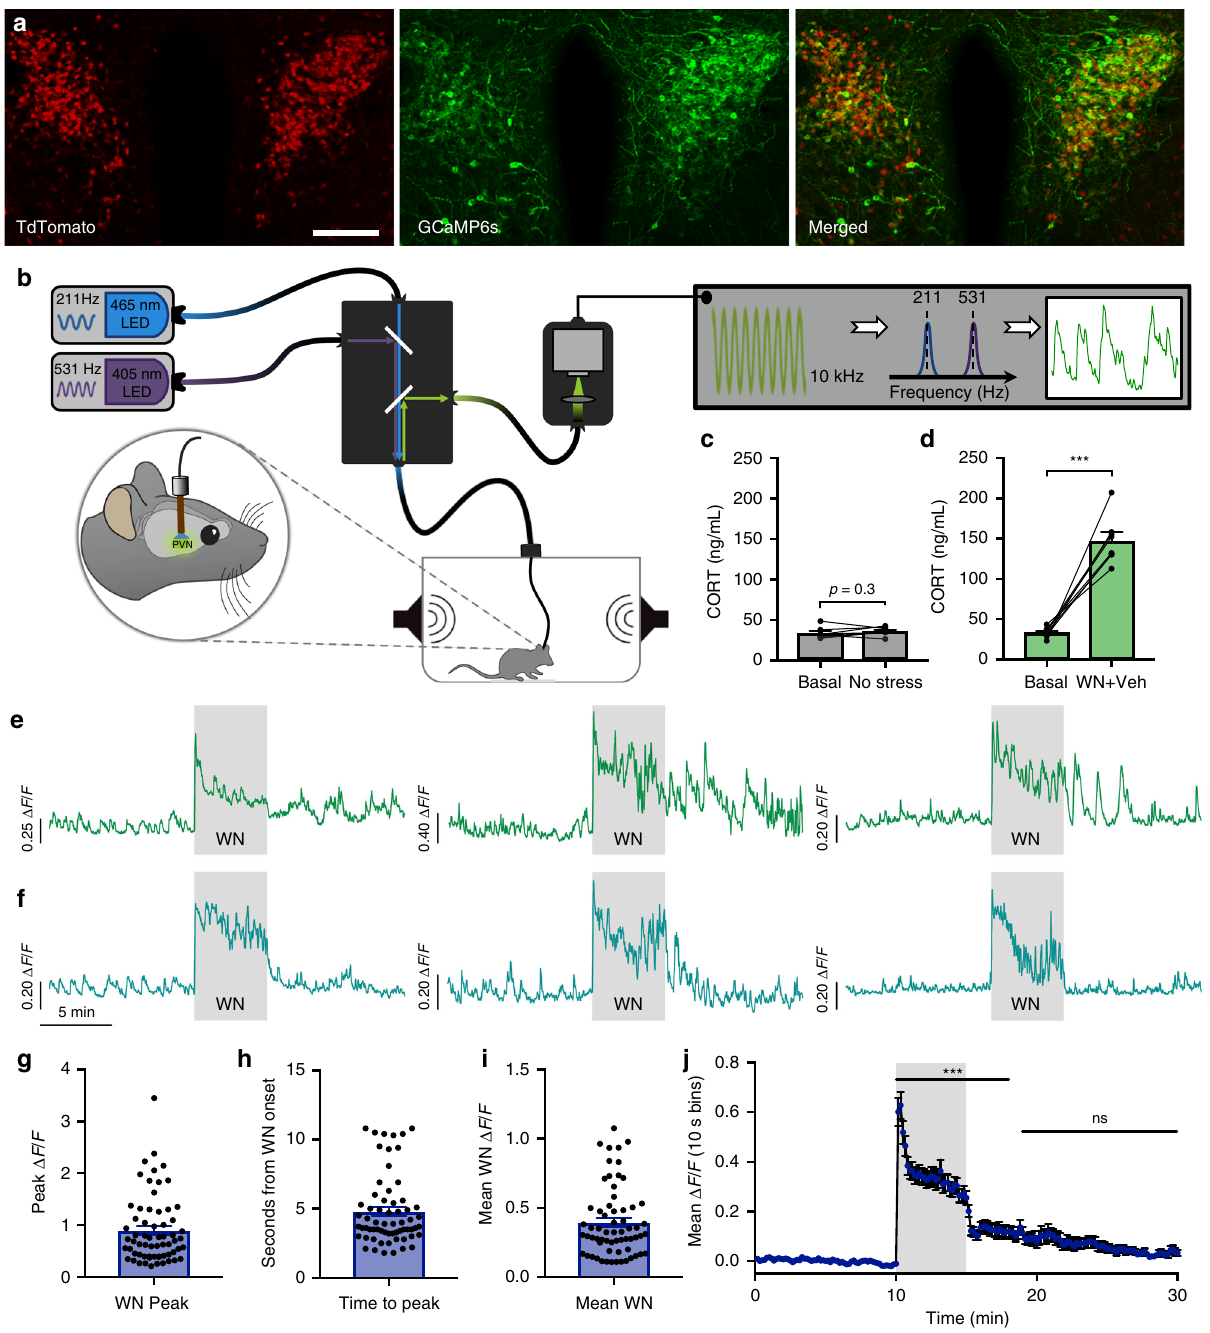
Fig. 1 Optical recordings of CRH neuron activity in freely behaving mice. a Image showing PVN expression of CRH-tdTomato reporter (left), AAV-driven GCaMP6s (center), and merged image (right). Scale bar: 100 μ m. b Schematic illustration of the fi ber photometry setup. c Blood CORT concentrations obtained from tail tip samples, while mice remained within experimental testing box in the absence of white noise (WN) stress; n = 8, p >0.05, paired t test. d Blood CORT concentrations following WN stress; n = 8, *** p <0.001, paired t test. e Photometry recordings of CRH neurons from three individual mice displaying continued activity after termination of WN. f Photometry recordings of CRH neurons from three individual mice displaying rapid cessation of activity after termination of WN. g Peak Δ F / F at WN stress onset, n = 64. h Time to peak from the onset of WN onset, n = 64. i Mean Δ F / F of CRH neuron activity during 5min WN stress from all individual mice tested, n = 64. j Mean CRH neuron Δ F / F in 10sec bins from all individual mice; n = 64, repeated-measures (RM) one-way ANOVA *** p <0.001 vs. baseline, Dunn ’ s post hoc test. All data are presented as CRH activity during and after white noise (WN1), respectively; activity during 5 min WN2: Veh-WN2 0.27 ± 0.05 Δ F / F vs. MET- Fig. 2d) and metyrapone-treated groups (0.43 ± 0.07 and 0.19 ± 0.04 Δ F / F , during and after WN1 respectively; Fig. 2d). Mean CRH neural activity during WN2 was also not different between vehicle and metyrapone treatment groups (mean CRH